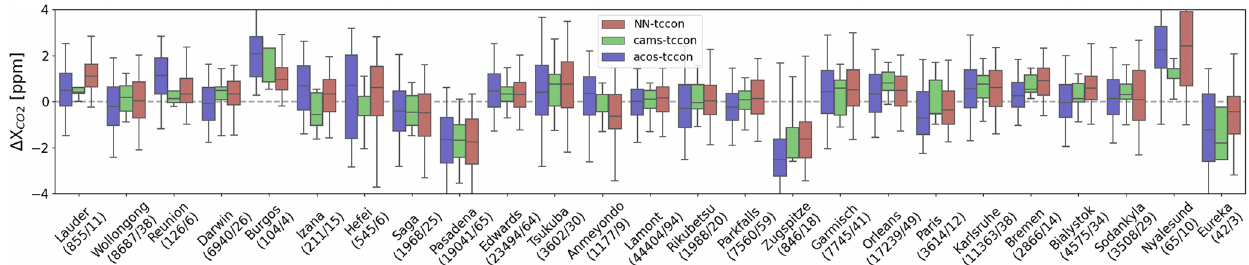
Figure 9. Statistics of the differences between the NN retrieval (red), the CAMS model (green), or the bias-corrected ACOS retrievals (blue) and the TCCON retrievals. The boxes indicate the 25%–75% percentiles, and the median is shown by the horizontal line within the box. The whiskers indicate the 5%–95% percentiles. Stations are ordered by increasing latitudes. The numbers below the station name indicate the number of individual observations and coincidence days used for the statistics. The references of the various TCCON observations are provided in Table 1. Figure A4 provides similar results for the glint